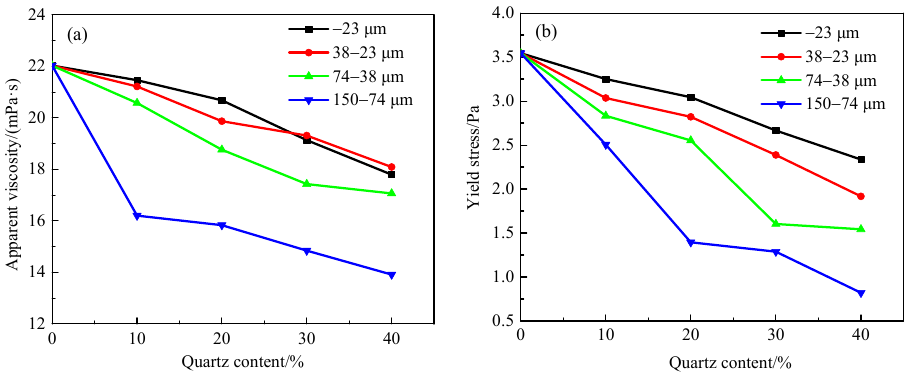
Figure 8. Effects of particle size on pulp’s ( a ) apparent viscosity and ( b ) yield stress of the mixed mineral of smithsonite-quartz using octadecylamine concentration: 150 mg/L at pH 9.5–10 and 28.57% solid concentration.